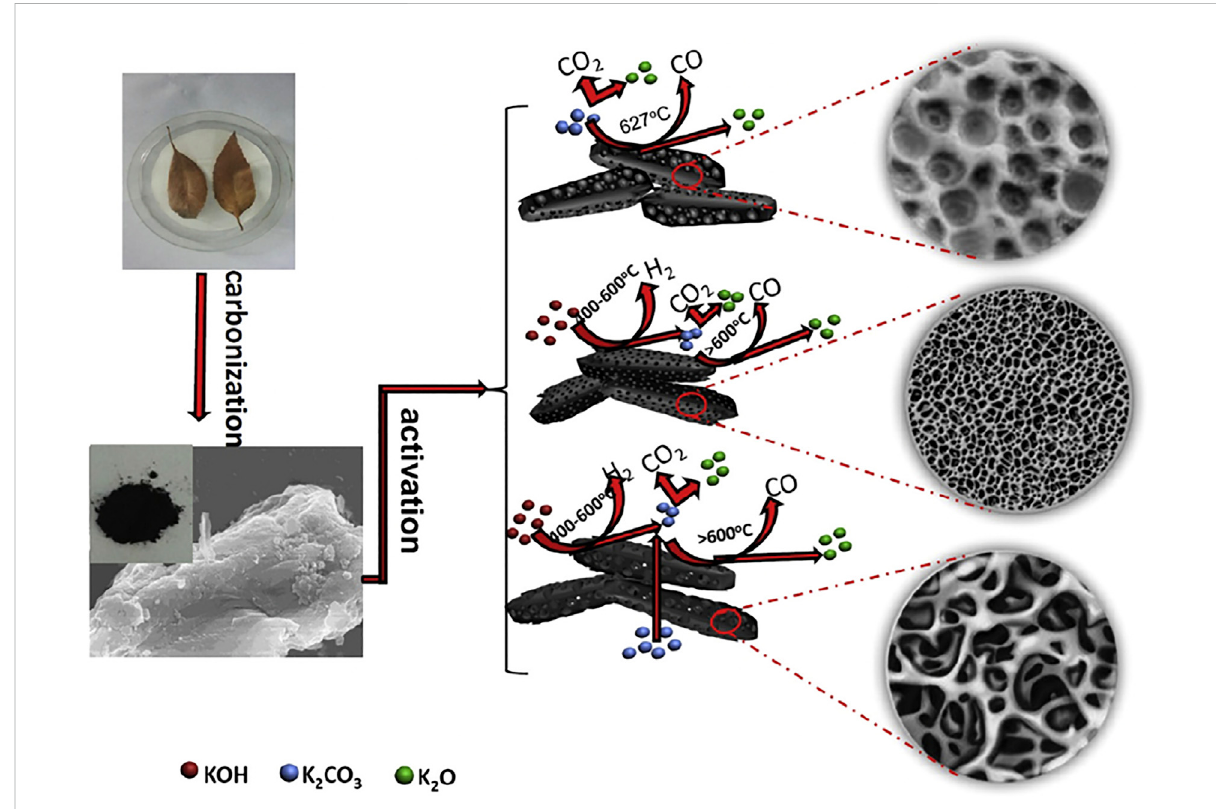
FIGURE 7 Activation process on ACs from fallen leaves by KOH and/or K 2 CO 3 (Li et al.,